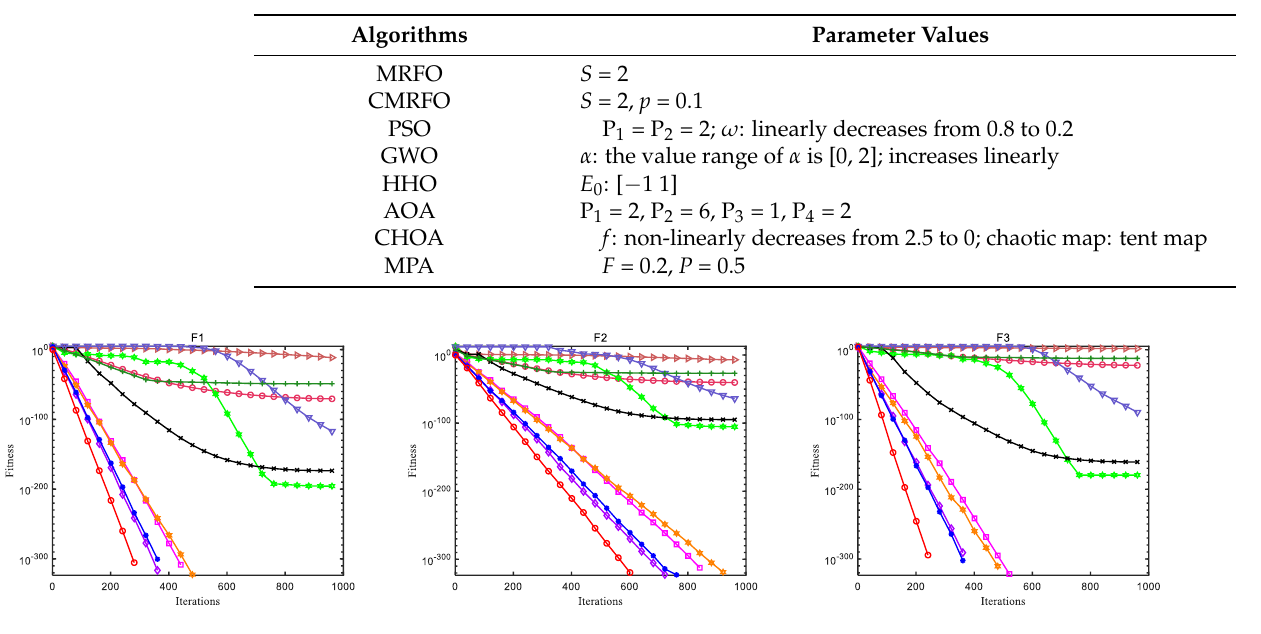
Table 5. Description of parameter settings.